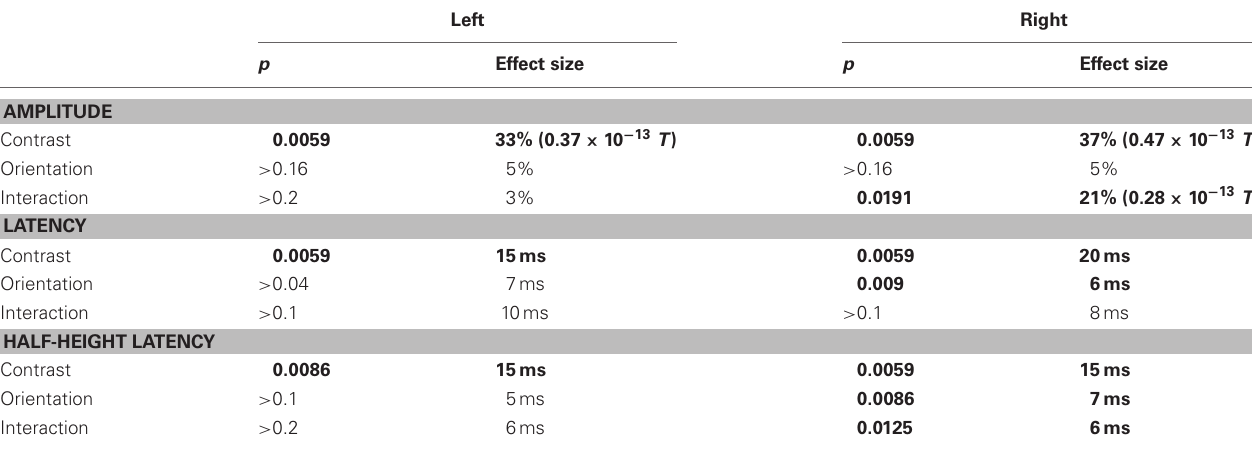
Table 2 | Results of the non-parametric (Wilcoxon) tests performed on Amplitudes, Latencies, and Half-height latencies. Left Right